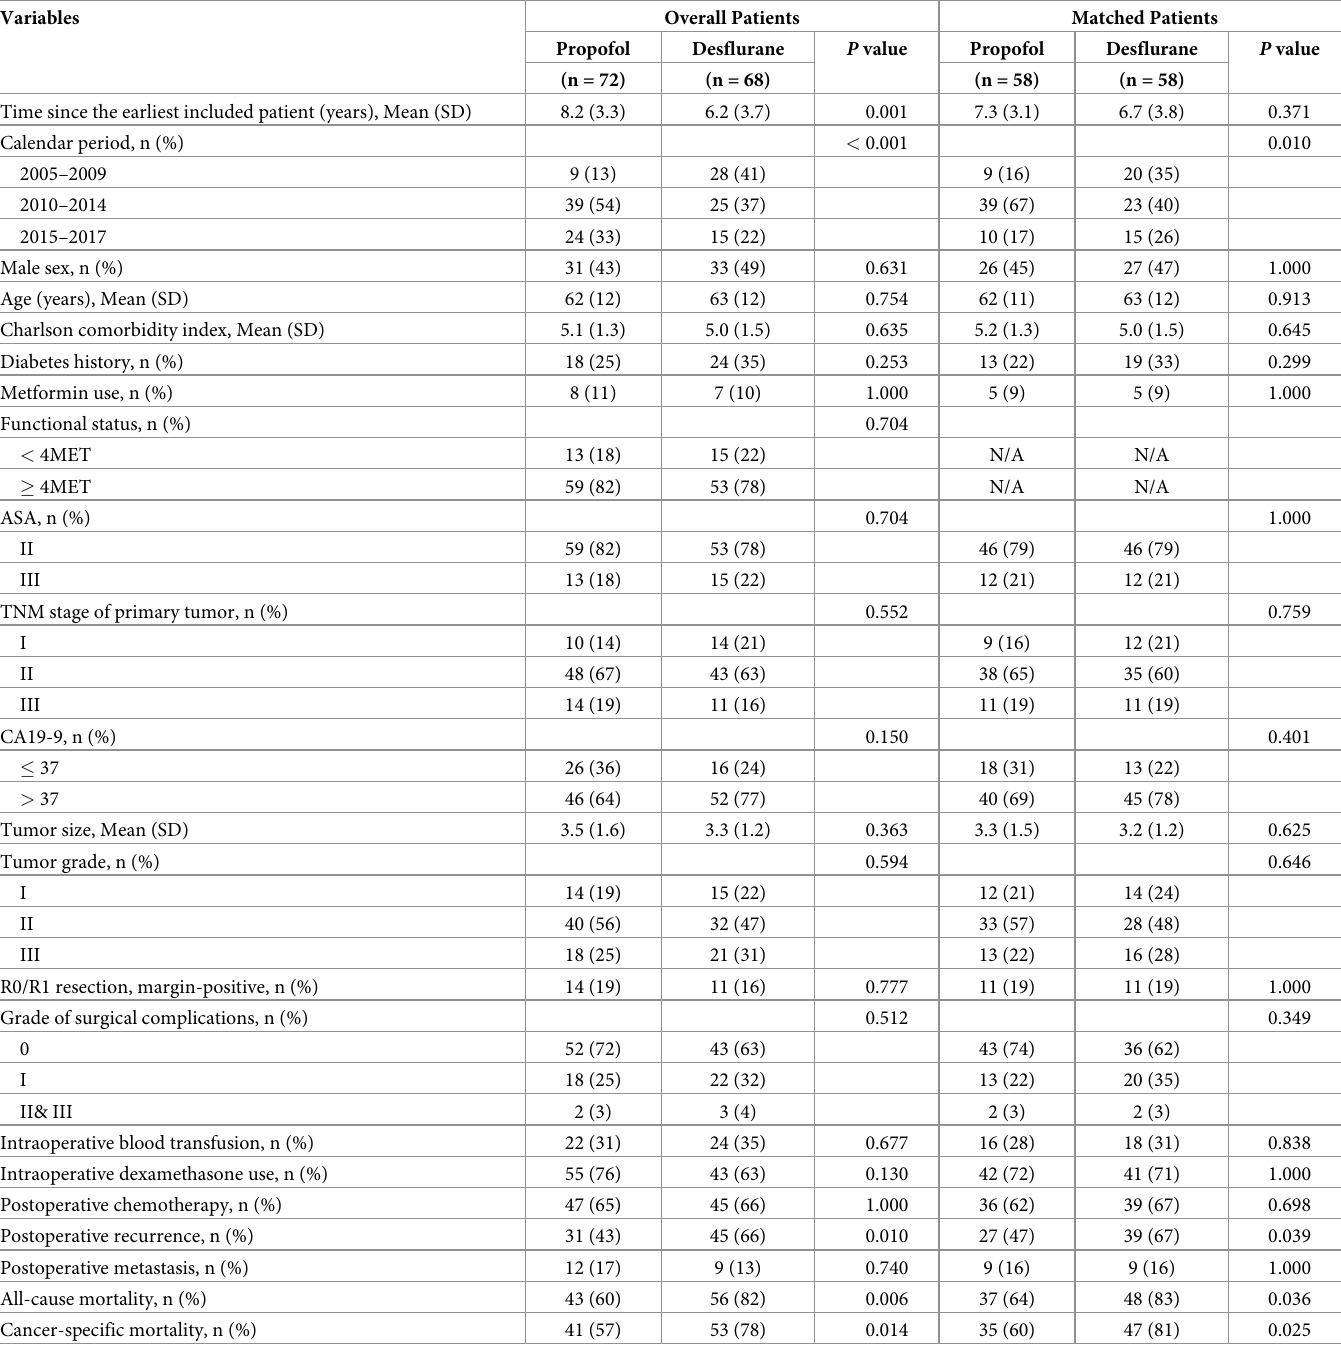
Table 1. Patients’ and treatment characteristics and clinical outcomes for overall group and matched group after propensity